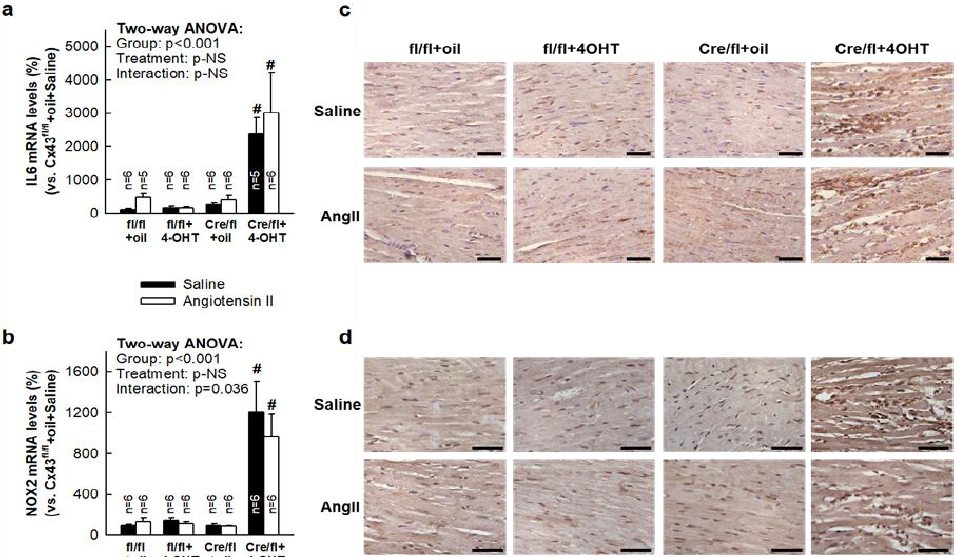
Figure 7. Expression of inflammatory markers in saline- and AngII-treated Cx43 fl / fl and Cx43 Cre-ER(T) / fl mice. Levels of mRNAs coding for IL-6 ( a ) and NOX2 ( b ), expressed as percentage vs. Cx43 fl / fl + oil mice treated with saline, in both Cx43 fl / fl (fl / fl) and Cx43-deficient mice (Cre / fl), implanted with osmotic pumps containing saline or AngII. # ( p < 0.05) shows significant di ff erences vs. Cx43 fl / fl mice injected with oil and infused with saline. ( c–d ) Immunohistochemical images of myocardial sections incubated with LAMP-2 / Mac-3 ( c ) or MMP9 ( d ) antibodies. Bar represents 50 µm.